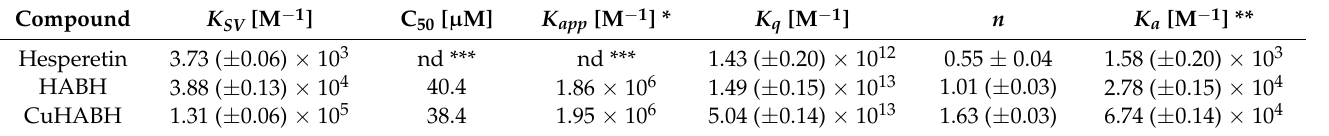
Table 3. TO-DNA fluorescence quenching parameters: Stern–Volmer constant ( K SV ), apparent